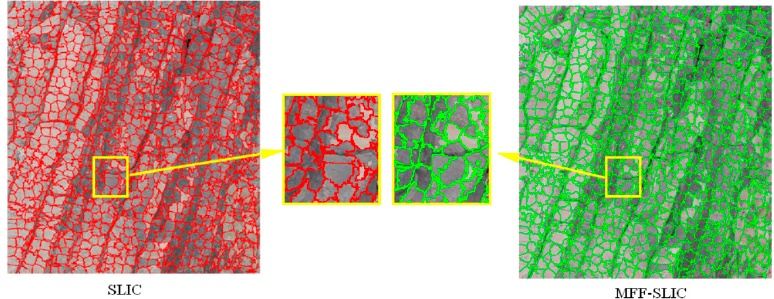
Figure 18. The comparison of segmentation results with 1000 superpixels.